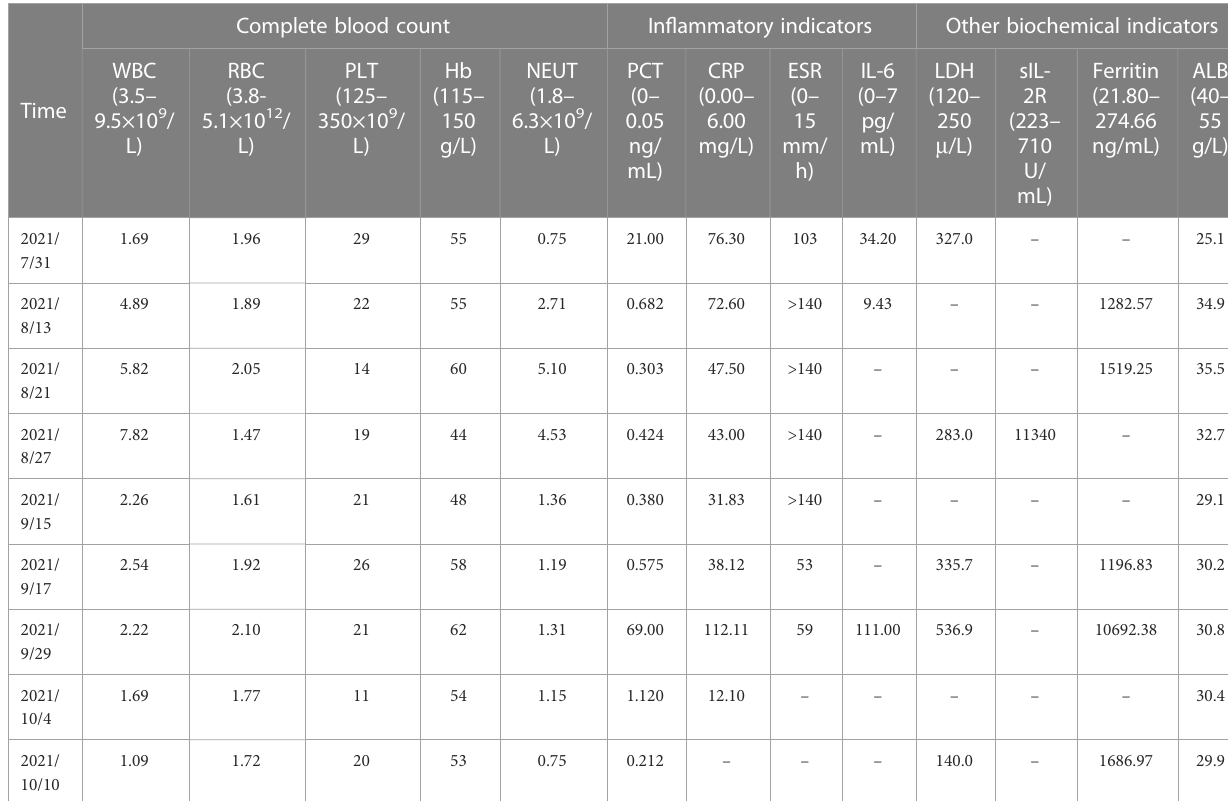
TABLE 1 Partial biochemical indicators from July to October 2021 *